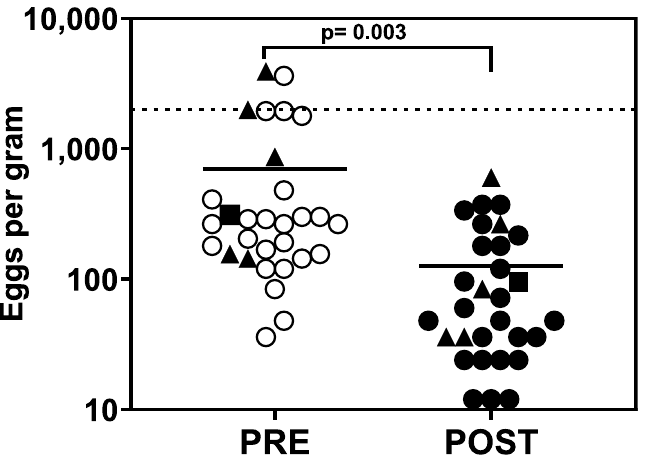
Figure 1. Kato-Katz microscopy was used to determine egg counts in fecal samples from each study subject before and after treatment. Each symbol represents an individual study subject. The dotted horizontal line shows the EPG threshold between light and moderate infection, as defined by WHO. The horizontal line represents the median EPG for each group. The triangles represent samples containing 2 or more amino acid residue changes present across both amplicons. The squares represent the pre- and post-treatment samples from study subject 5803, which contain both E198A and F200Y.